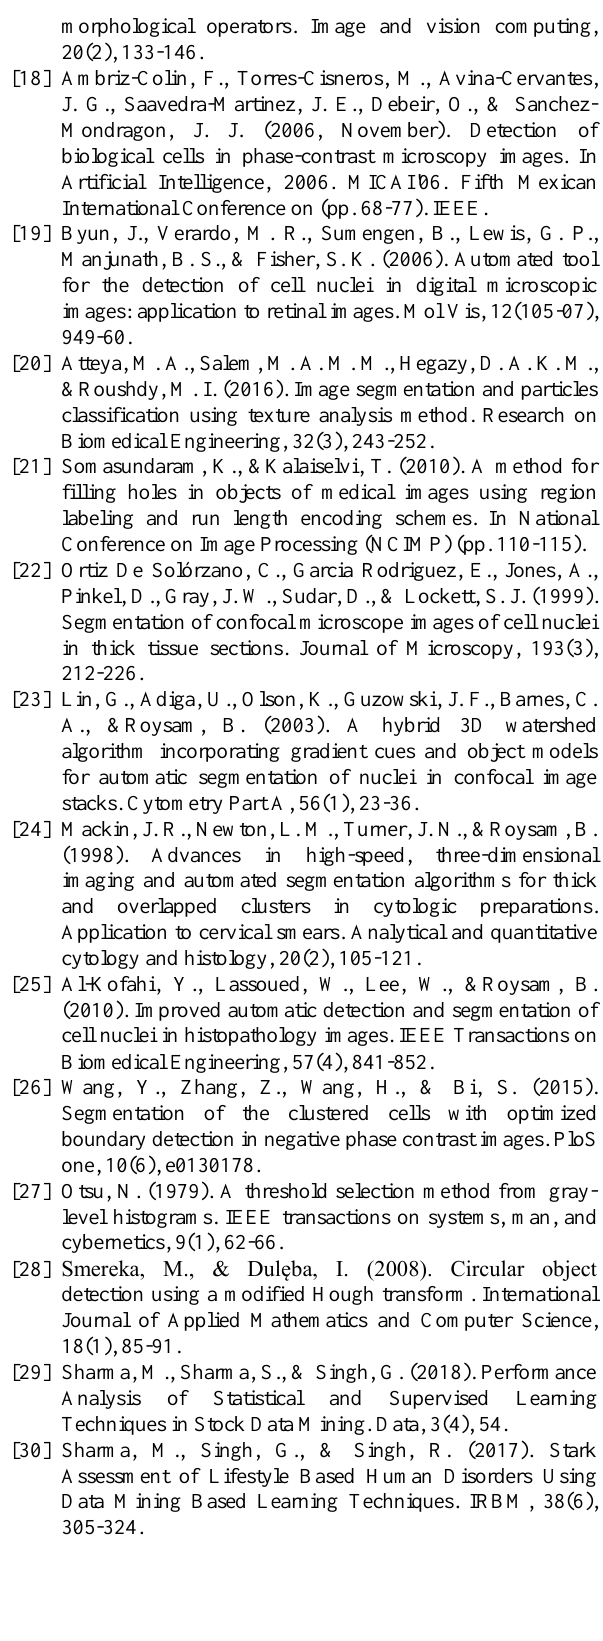
algorithm incorporating gradient cues and object